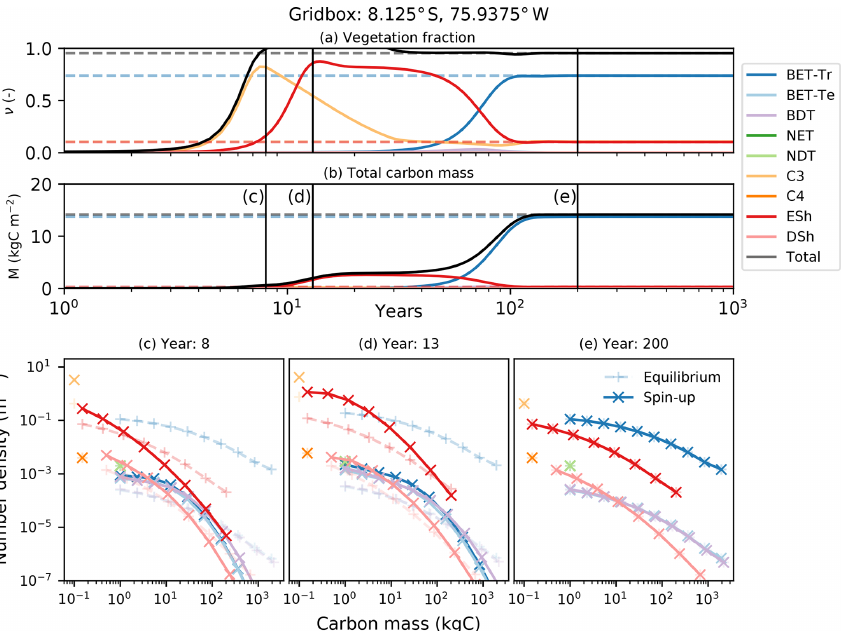
Figure 10. Dynamical runs of RED for a grid box at the edge of the Amazonian rainforest, starting from bare soil (solid lines) and the diagnosed equilibrium state (dashed lines). (a) PFT fractions versus time; (b) biomass versus time; (c–e) snapshots of the number density distribution of the PFTs across mass classes at different times. Lines marked as + are the equilibrium runs, while X indicates the spin-up run. The ultimate steady state is determined by the balance between recruitment and mortality (Eq. 6). Intra- and inter-PFT occurs here through the shading of seedlings, which implies that just a fraction of the grid box ( s , gap fraction) is available to grow seedlings (Eq.